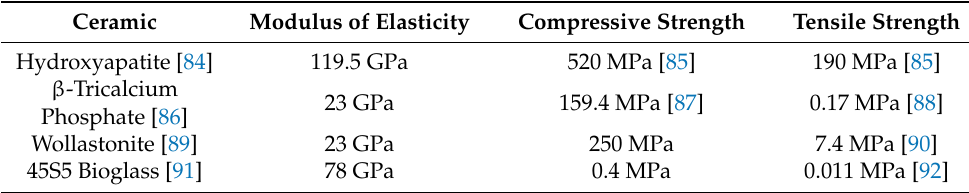
Table 6. Young’s Modulus on several popular ceramics that are used as